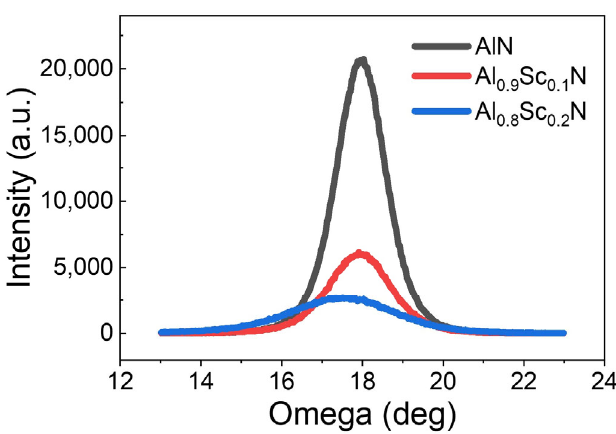
Figure 2. The XRD rocking curves of (0002) plane for AlN, Al 0.9 Sc 0.1 N and Al 0.8 Sc 0.2